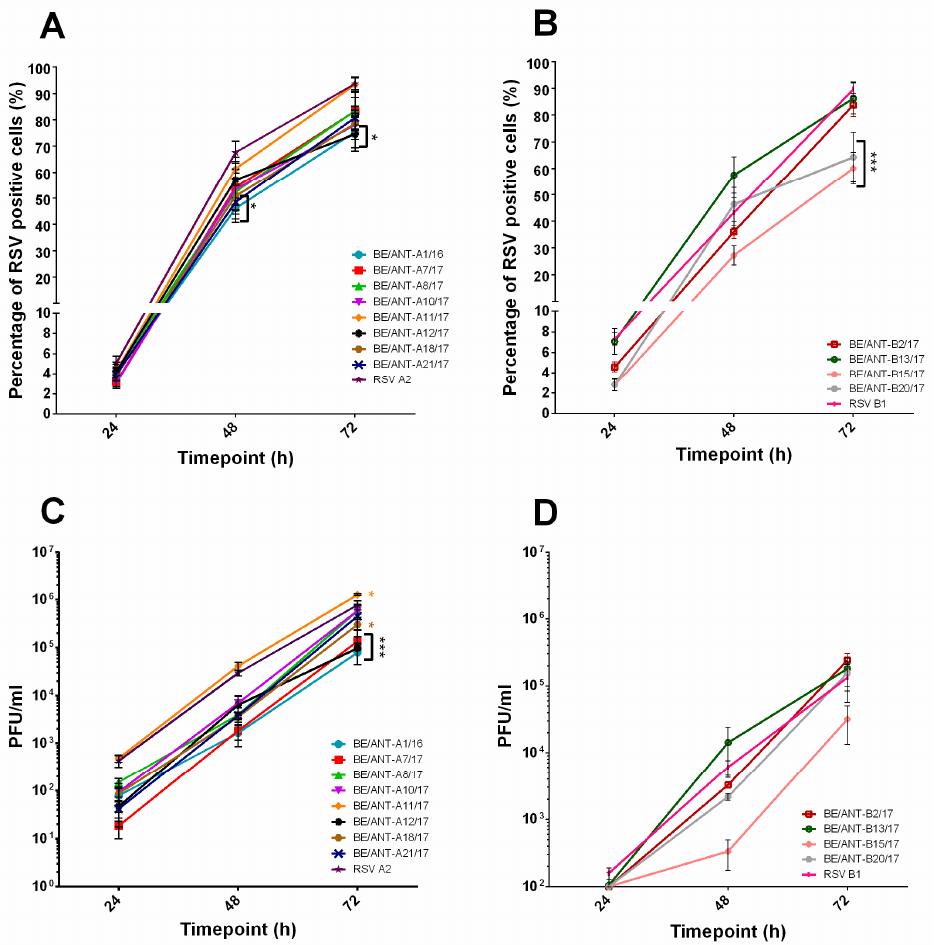
Figure 3. Replication kinetics and infectious virus production in A549 cells. ( A , B ) A549 cells were infected with clinical isolates and RSV reference strains A2 and B1. Cultures were fixed after 24 h, 48 h and 72 h, permeabilized and stained with pAb goat-anti-RSV antibody and AF488 donkey-anti-goat (IgG). Nuclei were visualized with DAPI and cultures were analysed with fluorescence microscopy. RSV positive cells were counted and calculated to the total number of nuclei to reach a percentage of RSV infected cells. ( A ) Replication kinetics of RSV-A clinical isolates and ( B ) Replication kinetics of RSV-B clinical isolates. ( C , D ) A549 cells were infected with clinical isolates and RSV reference strains A2 and B1. After 24 h, 48 h and 72 h, supernatants were collected and used for quantification by conventional plaque assay. Data represents mean values ± SEM ( n = 3), significant differences compared to the reference strains are indicated by * p < 0.05; *** p < 0.001 (two-way ANOVA).